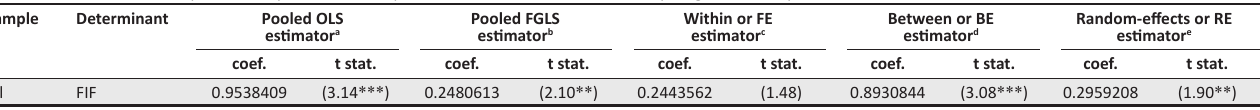
TABLE 2: Variation of Corruption Perceptions Index depends on fiscal freedom variable, by stage of development: All. Sample Determinant